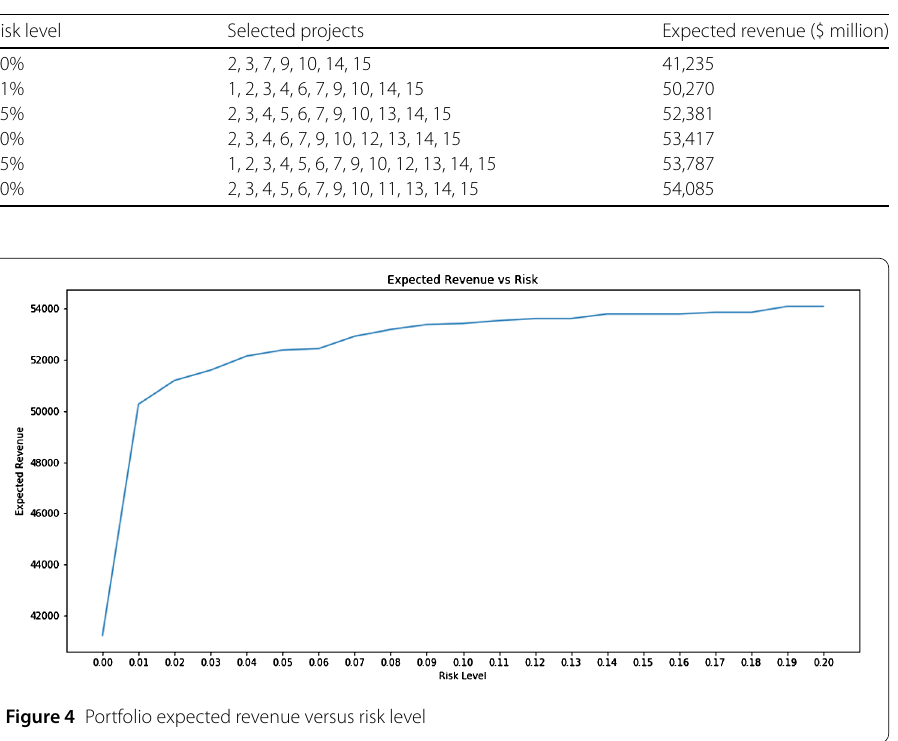
Table 3 Optimal project selection